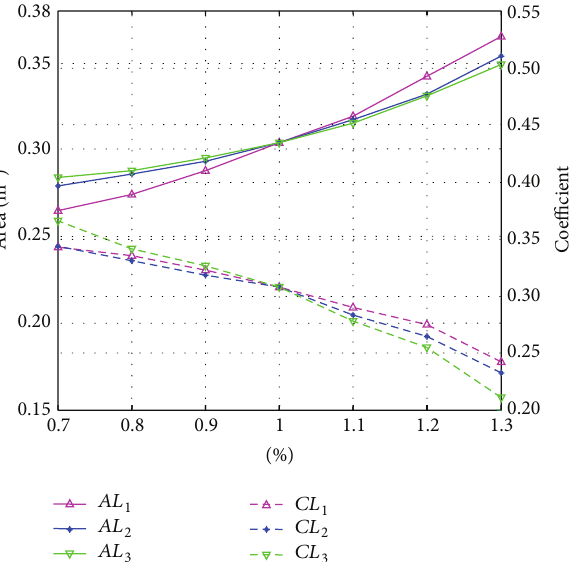
Figure 20: Relationship about link lengths, attainable space, and Manipulator Omnidirectional Coefficient.